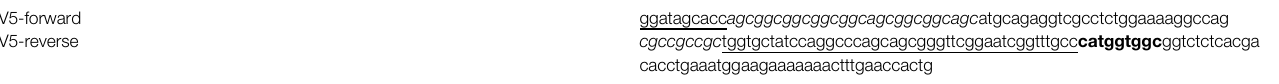
TABLE 1 | Primer and V5 sequences used to PCR amplify the pCCL-EF1 α -V5-CFTR vector.